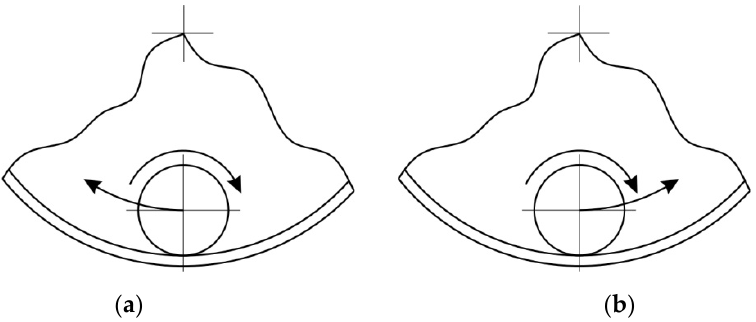
Figure 3 . Toolpaths strategies: ( a ) conventional and ( b ) climb Figure 3. Toolpaths strategies: ( a ) conventional and ( b )